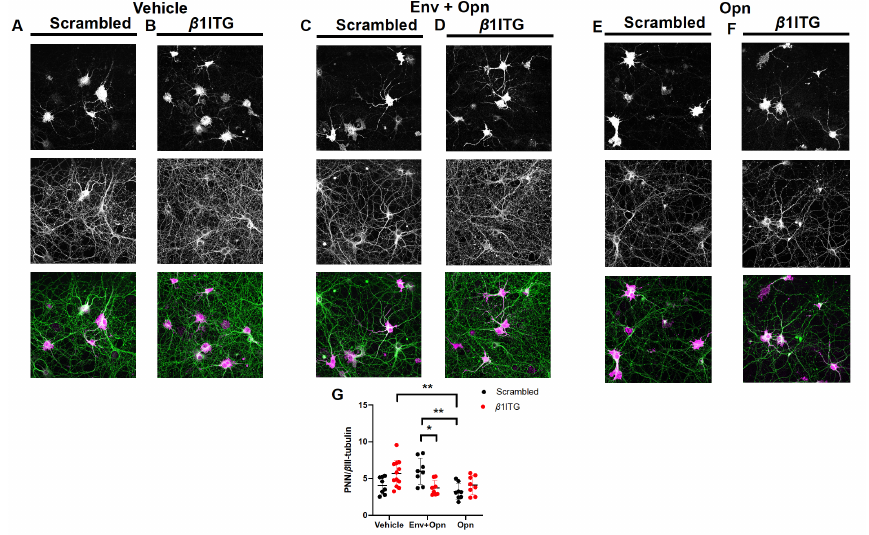
Figure 1. Cont . Figure 3. Perineuronal net (PNN) expression is decreased in β 1 integrin silenced neurons in